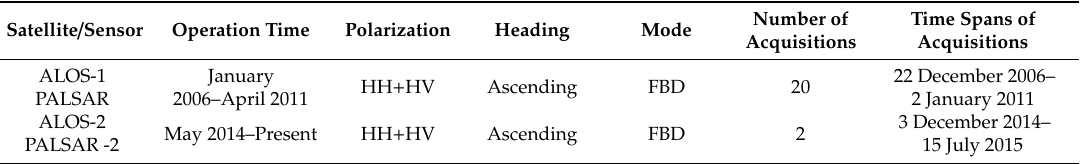
Table 1. ALOS PALSAR and ALOS-2 PALSAR-2 information. HH + HV represents dual polarization, FBD represents fine beam dual polarization mode.